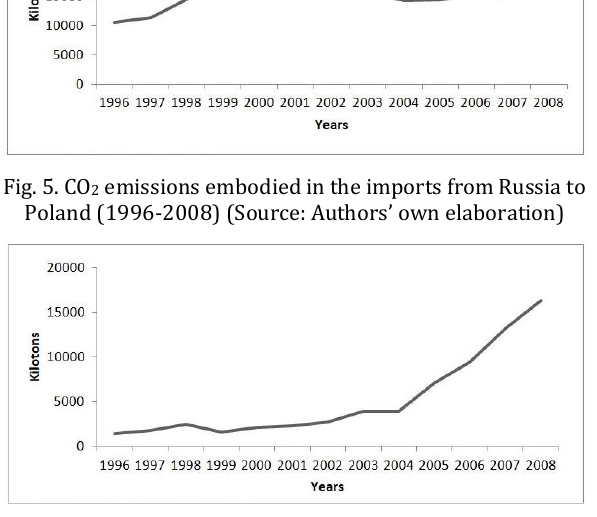
Fig. 6. CO 2 emissions embodied in the imports from China to Poland (1996-2008) Source: Authors’ own elaboration